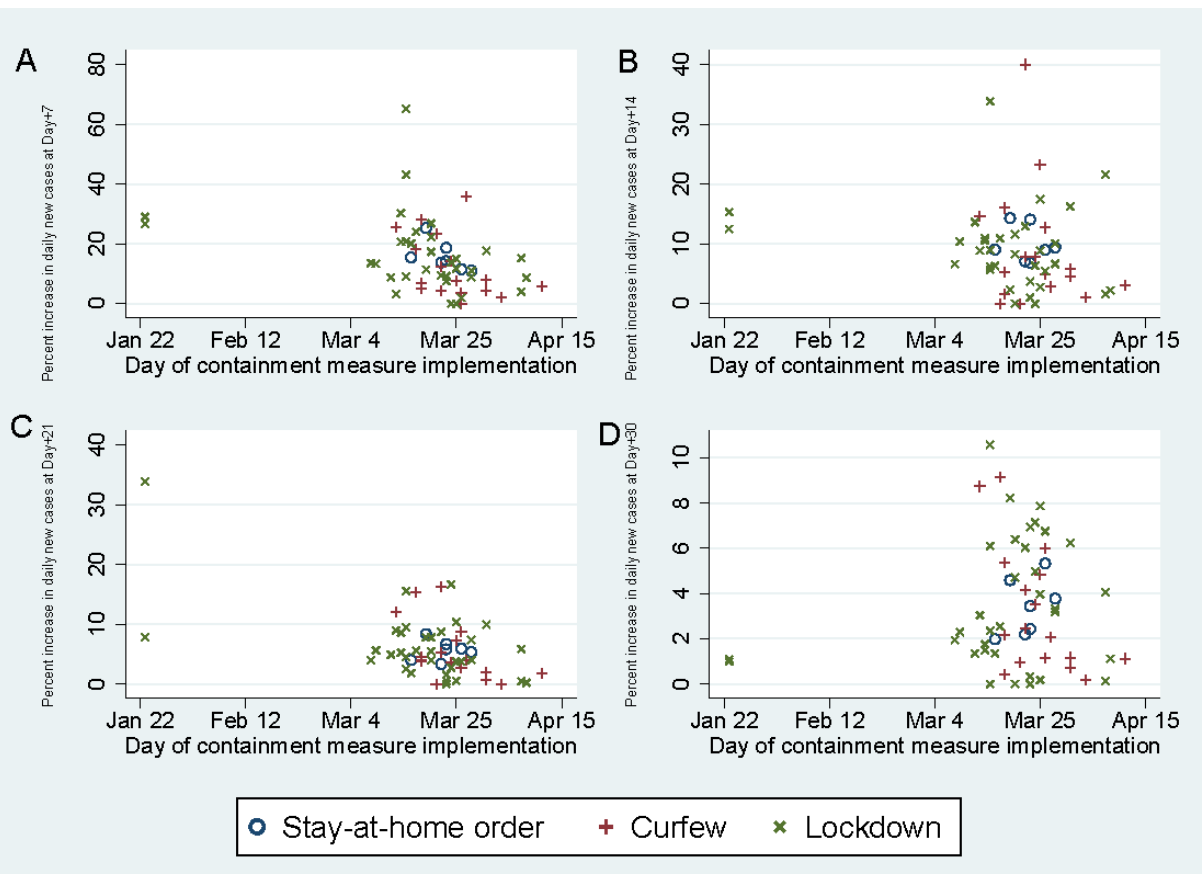
Figure 7. Percent increases in daily new cases at day +7 (A), day +14 (B), day +21 (C), and day +30 (D) vs start date of containment measure by type of containment